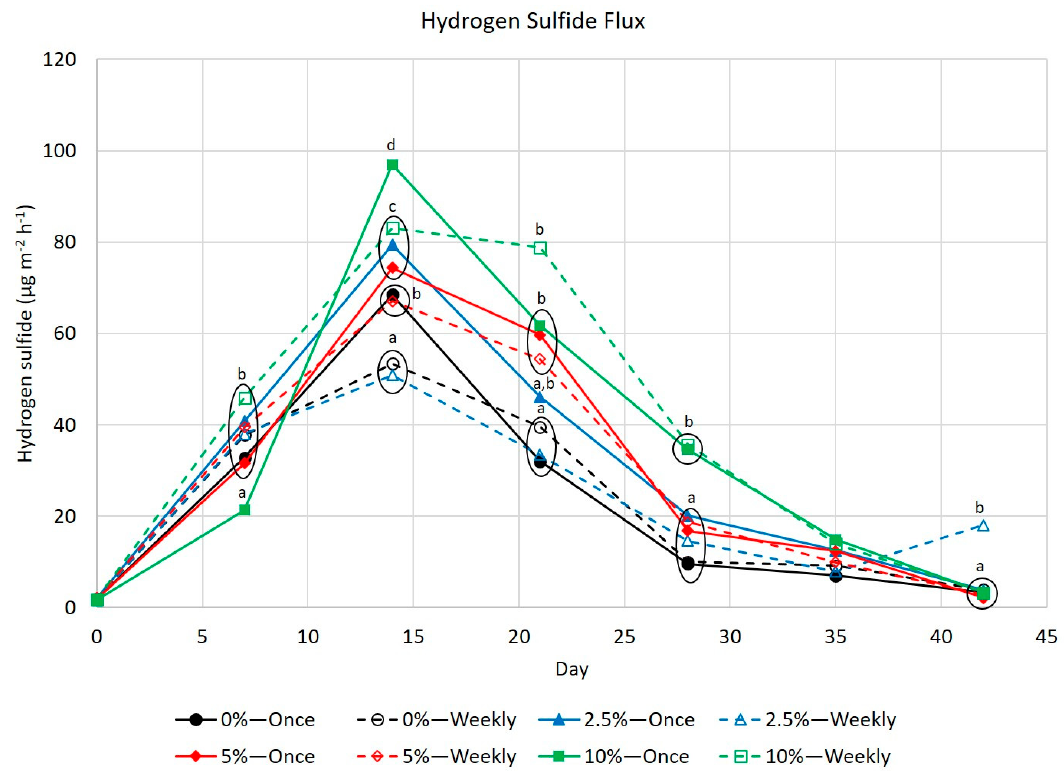
Figure 6. Average hydrogen sulfide flux (µg m − 2 h − 1 ) for weekly measurements taken over 42 days for bedded packs treated with 0, 2.5, 5, and 10% alum either in one dose or in weekly doses. Alum × Dose × Day interaction p < 0.01, pooled standard error of the mean = 4.62. Clusters with different letters indicate significant differences p < 0.05 .